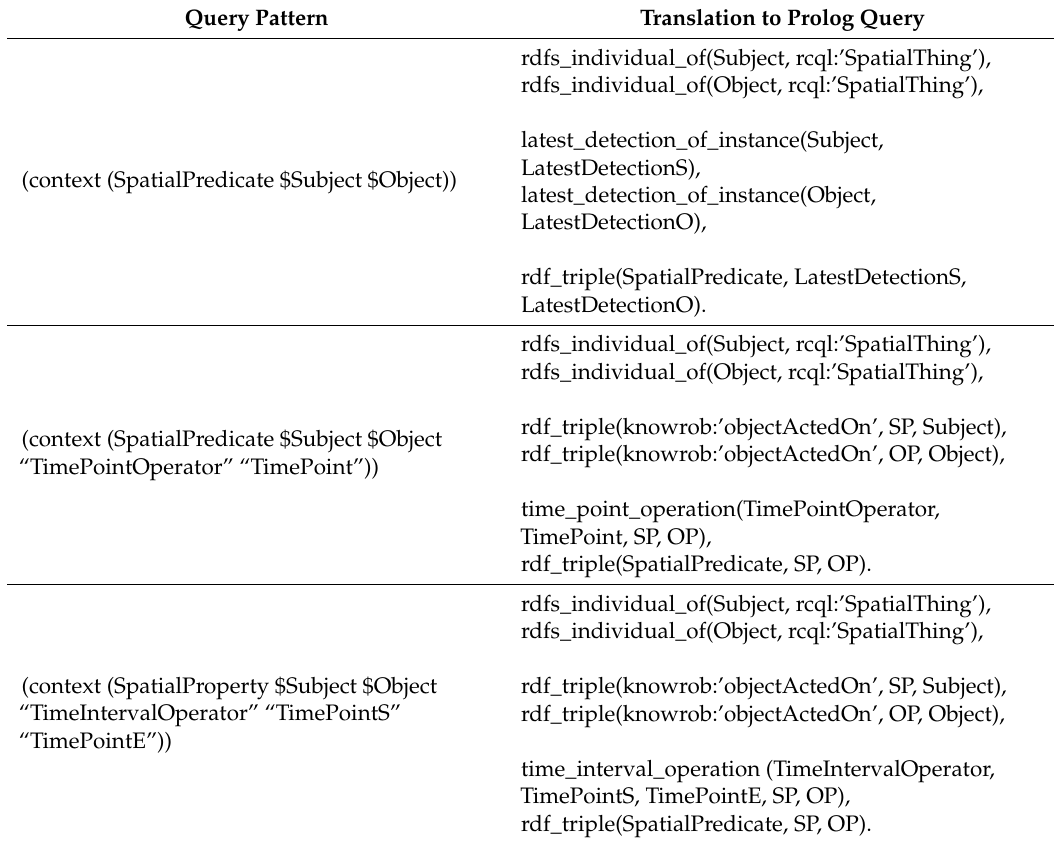
Table 1. Rules of query